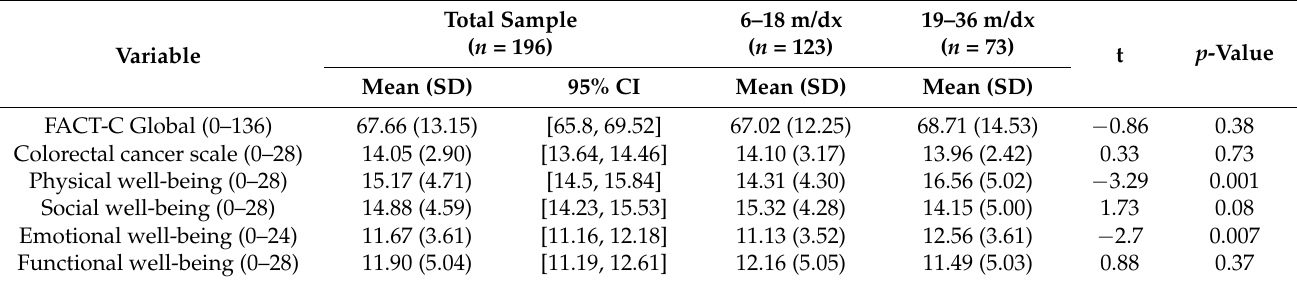
Table 2. Means and t -tests to compare quality of life by time from diagnosis among young adult colorectal cancer survivors ( n =